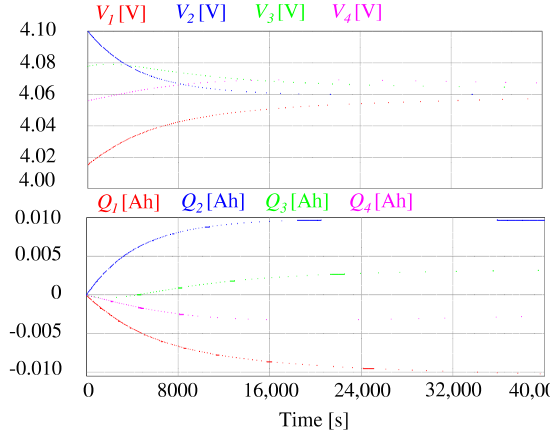
Figure 29. Equalization of a four-cell battery bank using the switched capacitor–inductor network